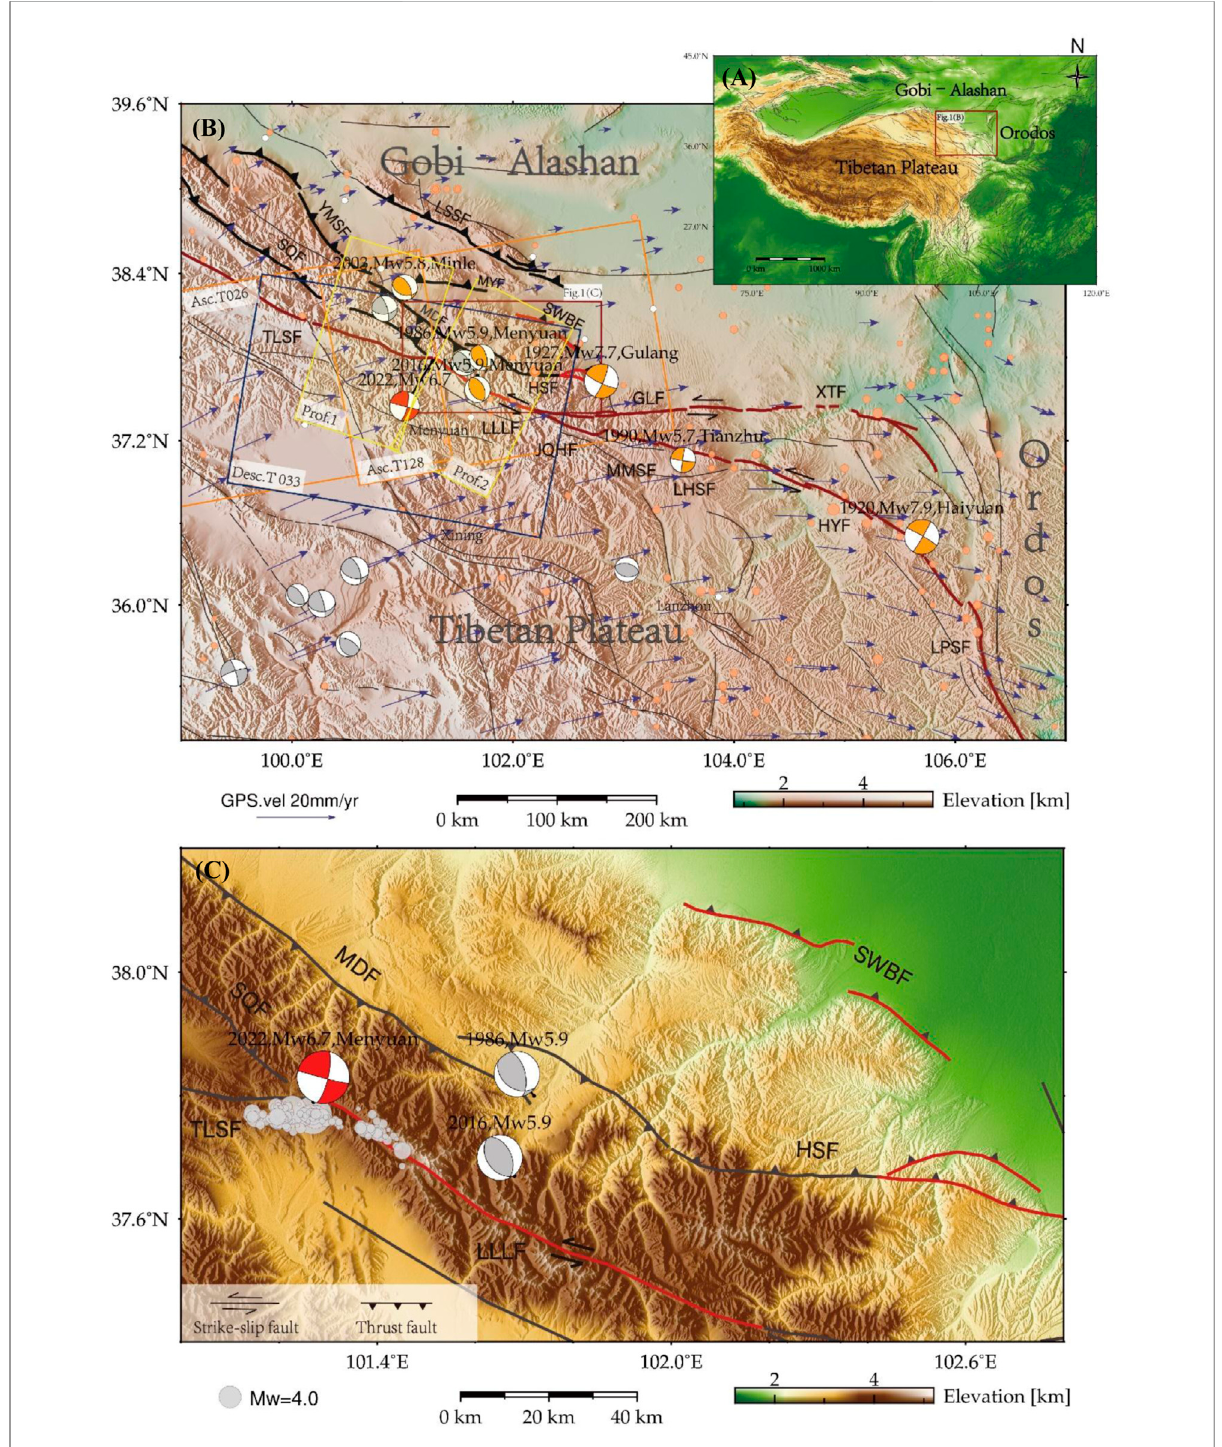
FIGURE 1 Tectonic settingof the2022 Mw6.7 Menyuan earthquake. (A) Tectonic setting of theQilian – Haiyuanfault (QL – HYF) zone. (B) Main faults inthe NE Tibetan Plateau. Active faults are from Deng et al. (2007) (https://www.activefault-datacenter.cn/map). The Mw 5.7 + historical earthquakes that occurred along the QL – HYF zone since 1920 are marked by the GCMT focal mechanisms. Arrows indicate GPS velocities from Wang and Shen, (2020). The orange and blue rectangles outline the coverage of ascending and descending Sentinal-1 SAR data. Two yellow rectangles outline the coverage of the GPS pro fi les across the TLSF and LLLF, which are shown in Supplementary Figure S1. TLSF: Tuolaishan fault; LLLF: Lenglongling fault; JQHF: Jinqianghe fault; MMSF: Maomaoshan fault; LHSF: Laohushan fault; HYF: Haiyuan fault; LPSF: Liupanshan fault; GLF: Gulang fault; XTF: